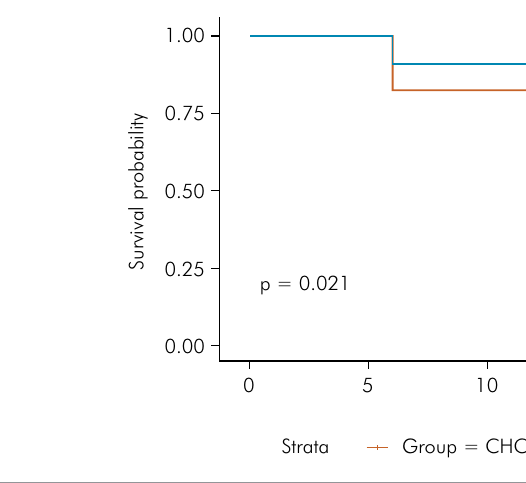
Figure 2. Kaplan-Meier curve of the survival analysis of restorative procedures.